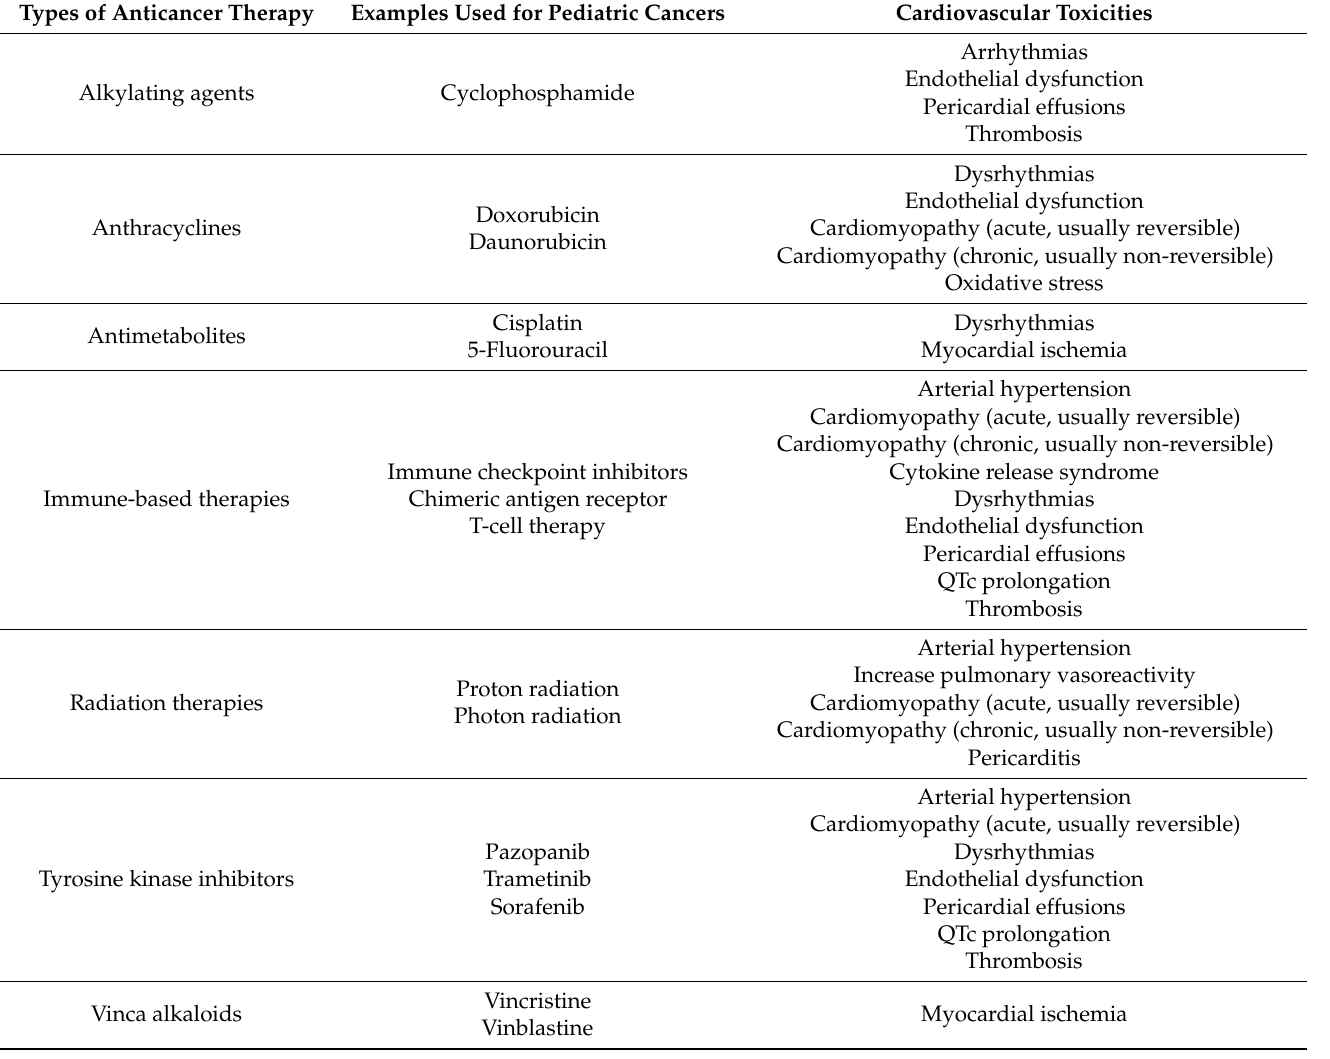
Table 1. Common anticancer therapies associated with cardiovascular toxicity